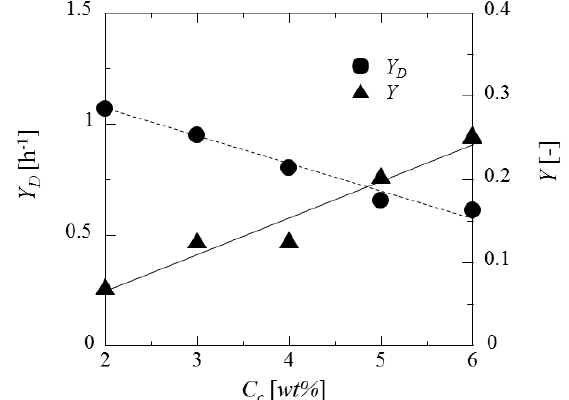
Figure 14. Dependence of drying rate and equilibrium weight fraction on curdlan concentration.